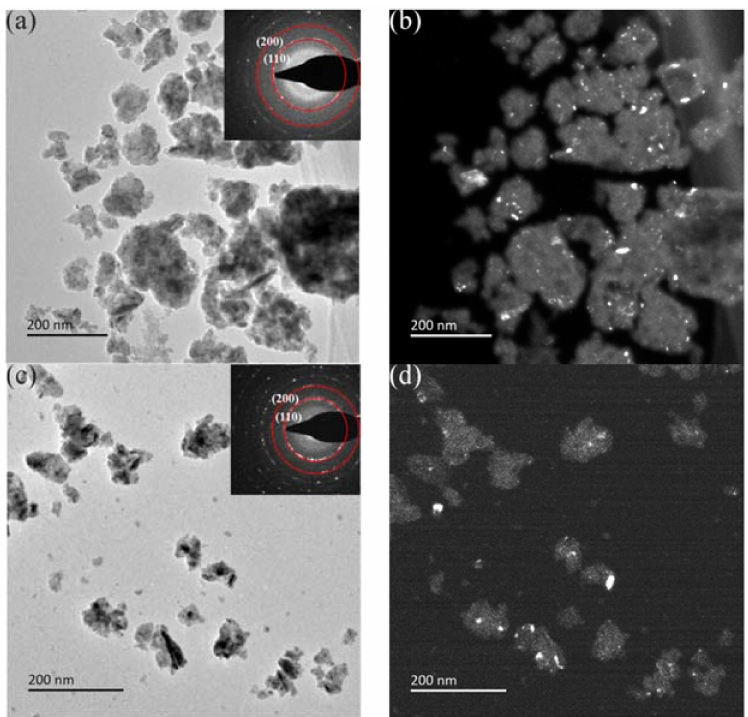
Figure 8. The TEM images of ball-milled tungsten powder with different additive amounts of PCA. ( a ) 6% PCA, 700 rpm, 60 h, BF TEM image; ( b ) 6% PCA, 700 rpm, 60 h, DF TEM image; ( c ) 12% PCA,